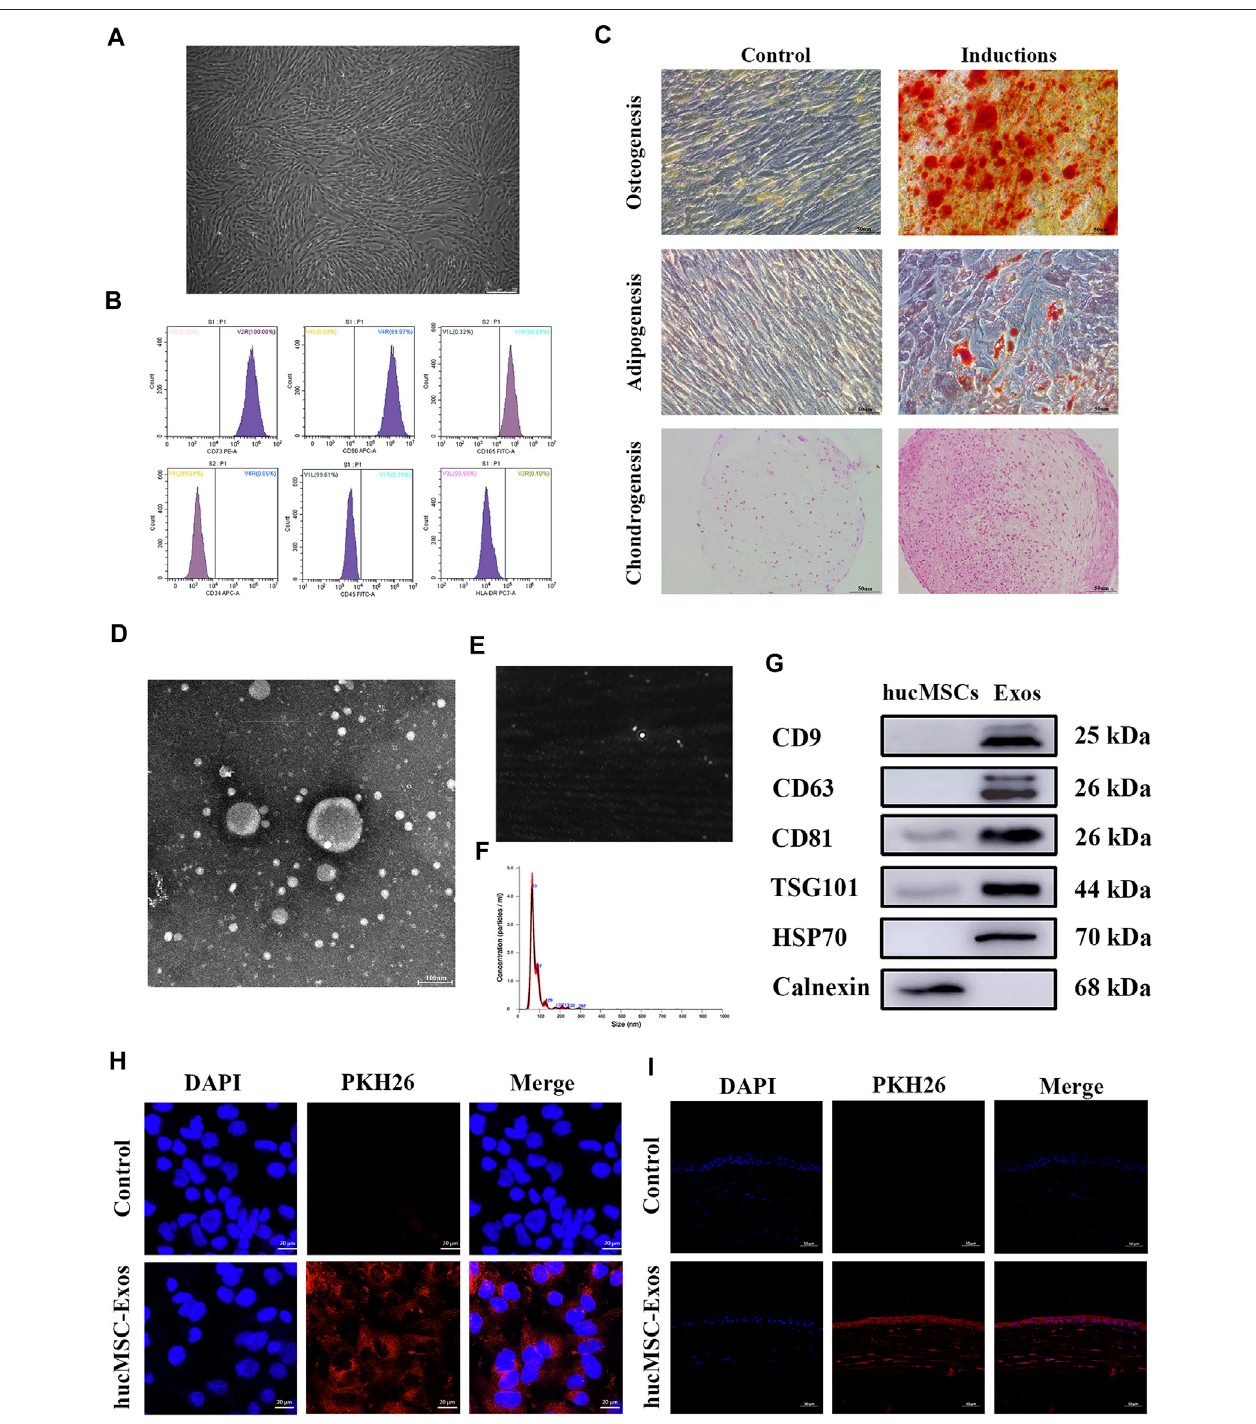
FIGURE 2 | Identi fi cation of human umbilical cord mesenchymal stem cells (hucMSCs) and exosomes secreted from human umbilical cord mesenchymal stem cells (hucMSC-Exos). (A) Microscopic images of hucMSCs morphology. Scale bar: 250 μ m. (B) Flow cytometry results for expression of stem cell surface markers CD73, CD90, CD105, CD34, CD45, and HLA-DR. (C) Alizarin red, Oil Red O, and Safranine O staining for osteogenic, adipogenic, and chondrogenic differentiation. Scale bar: 50 μ m. (D) TEM images of hucMSC-Exos morphology. Scale bar: 100 nm. (E,F) NTA-determined size distribution of hucMSC-Exos. (G) Western blotting showing the expression of the markers (CD9, CD63, CD81, TSG101, HSP70, and Calnexin) of hucMSC-Exos. The lysate of hucMSCs served as the control group. (H) Uptake ofhucMSC-Exos by HCECs in vitro . PBS wasused as anegativecontrol. Scale bar: 20 μ m. (I) Uptake ofhucMSC-Exos by cornea in vivo . Scale bar: 50 μ